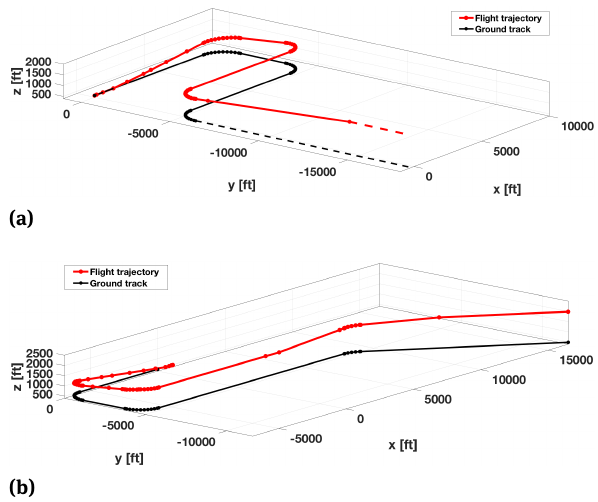
Figure 1: Three-dimensional trajectories for (a) departure and (b) arrival. Milan-Bresso RWY18 right-hand standard circuit. Discretiza- tion based on ECAC prescription for noise emission analysis, con- sidering flight performance of a Cessna C172R